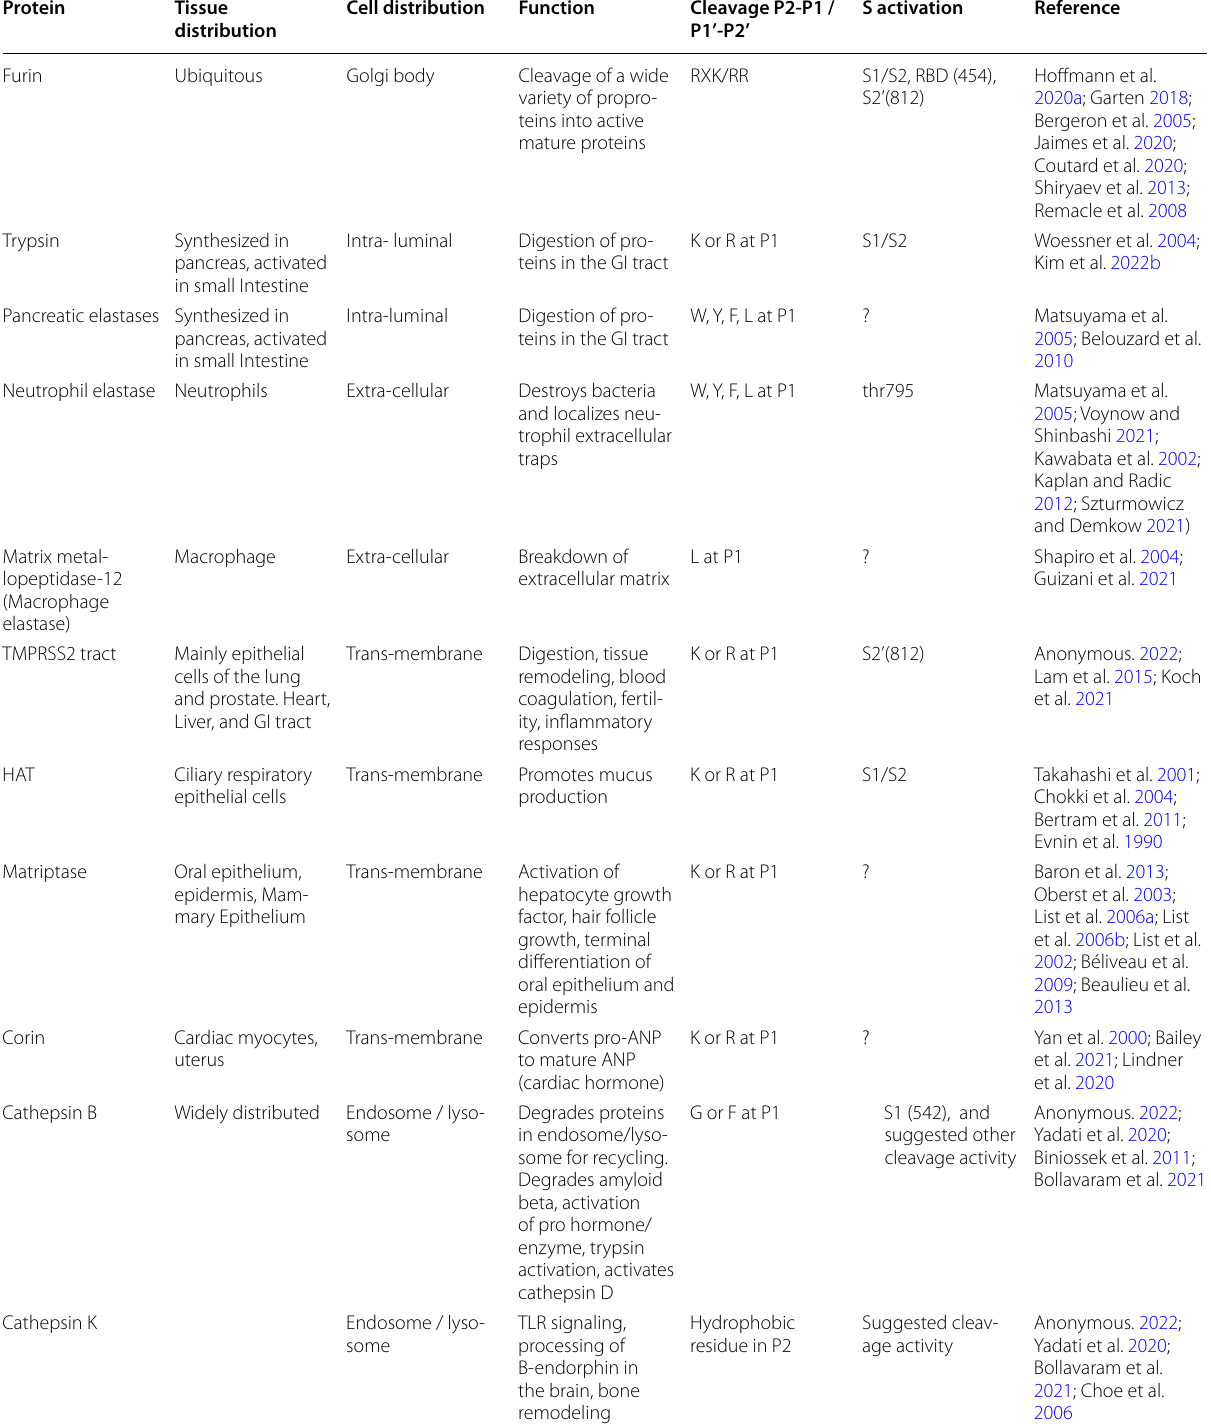
Table 1 Summary of host proteases on their distribution, function, cleavage specificity and potential roles in SARS‑CoV‑2 S activation